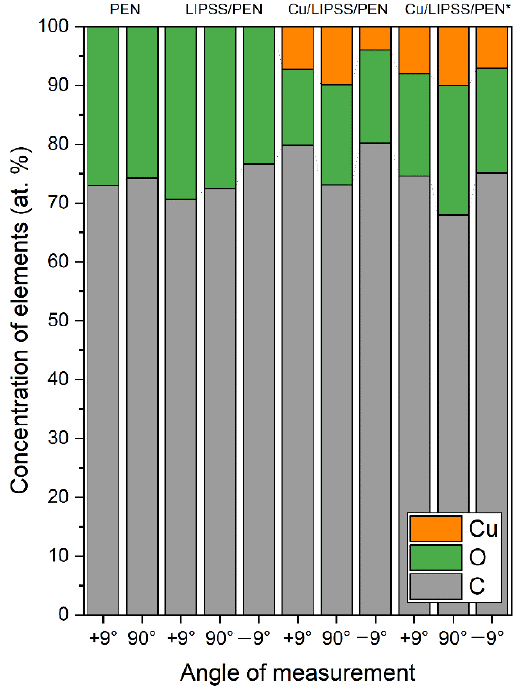
Figure 4. Atomic concentrations of elements (Cu, C, O) derived from XPS analysis for pristine PEN, LIPSS/PEN, and Cu/LIPSS/PEN immediately after Cu deposition (Cu/LIPSS/PEN) and 4 months after Cu deposition (Cu/LIPSS/PEN*).